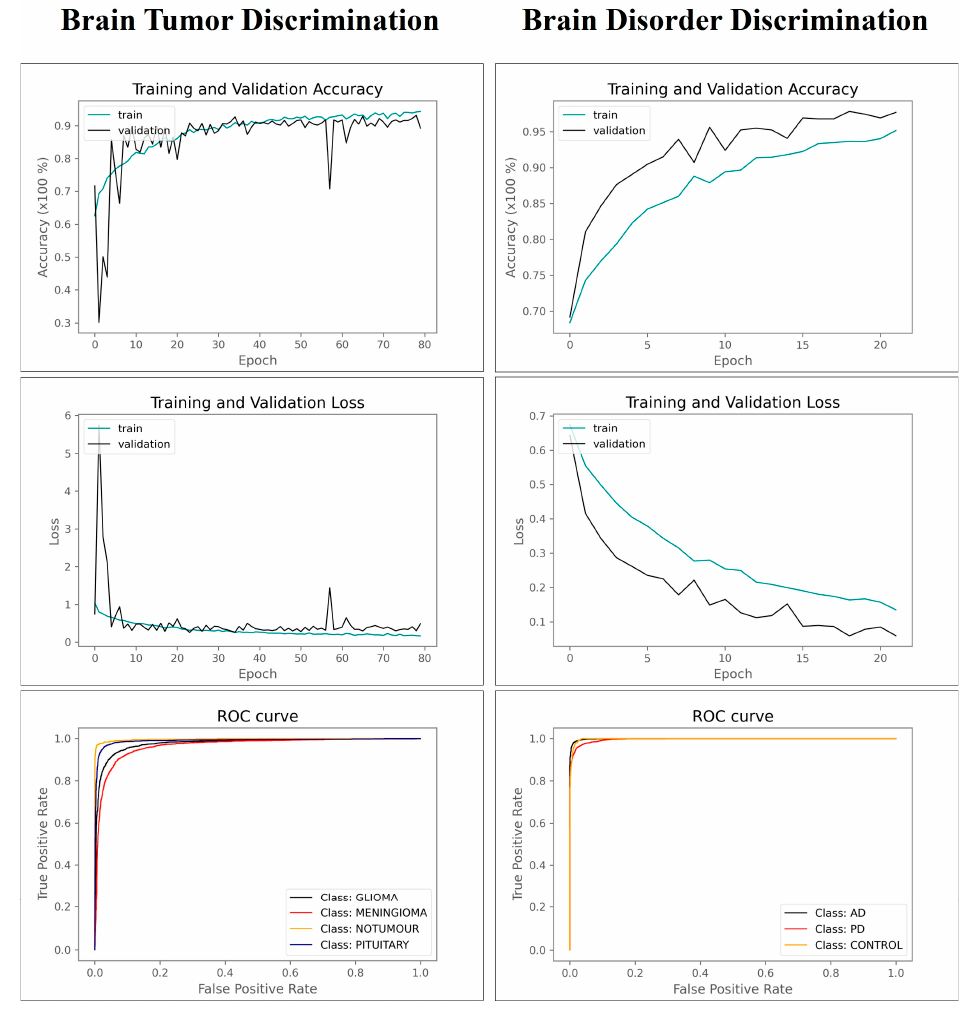
Figure 2. Training–validation accuracy–losses and ROC curve of AFF-VGG19.